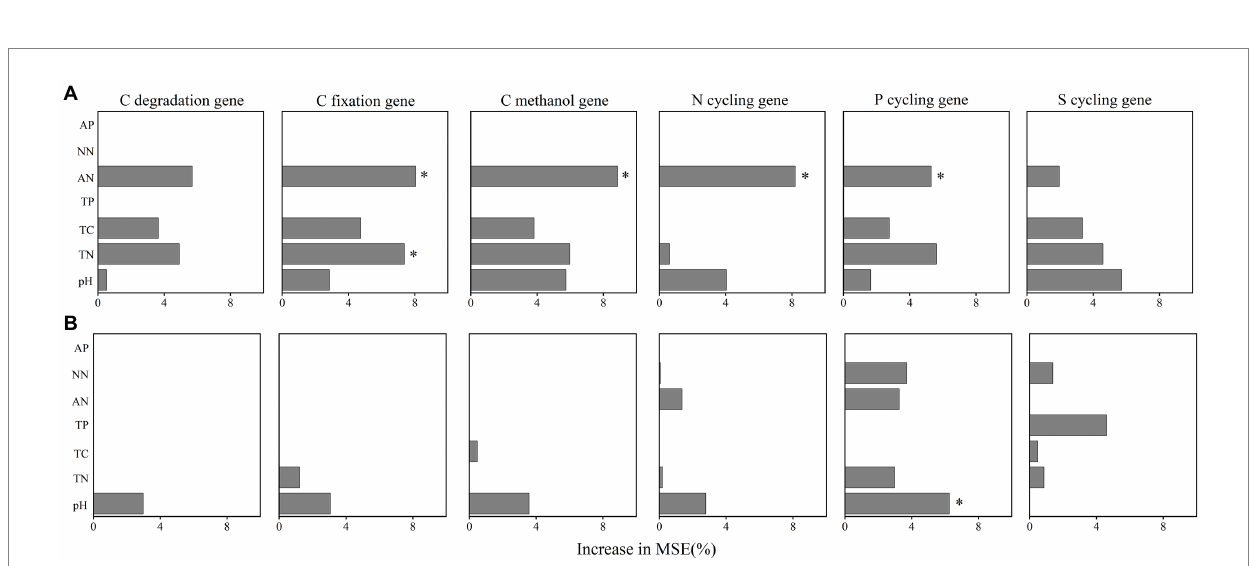
FIGURE 7 The importance of edaphic variables in explaining the variations functional genes’ abundances in A . palmeri (A) and native (B) rhizosphere soils. Random forest was used to determine the variable importance. Percentage increases in the MSE (mean squared error) of variables were used to estimate the importance of these predictors, and higher MSE% values imply more important predictors. Significance levels are as follows: * p < 0.05. MSE, mean squared error. The redundancy analysis (RDA) of edaphic variables on functional gene structure in A . palmeri (A) and native (B) rhizosphere soils. * p < 0.05, ** p < 0.01). TN, total nitrogen; TC, total carbon; TP, total phosphorus; AN, ammonium nitrogen; NN, nitrate nitrogen; AP, available